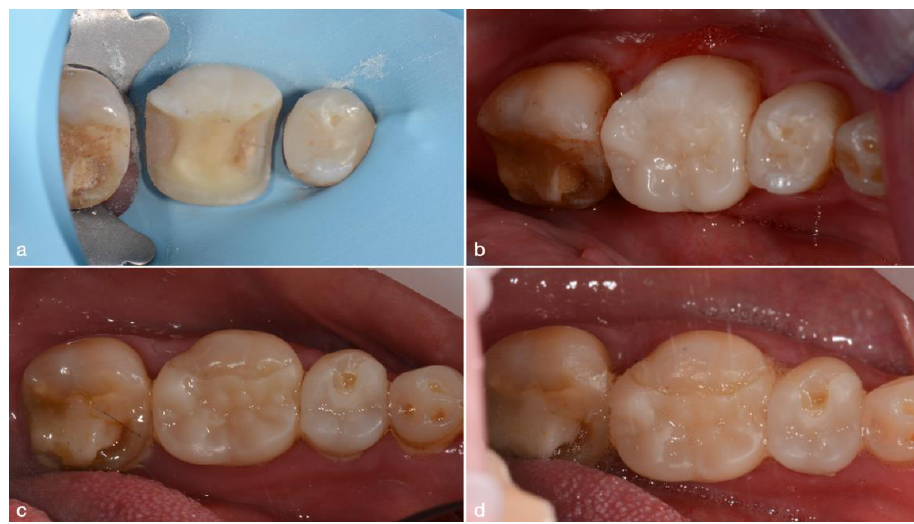
Figure 3. Images and descriptions of follow-up cases. Marginal adaptation: ( a ) Preparation at placement appointment; ( b ) immediately after placement of onlay on #36; ( c ) unintentional follow-up after 7 months of #36 due to placement of onlay on #35; ( d ) 36-month follow-up of #36. Table 5. USPHS scores and Chi-Square statistics at baseline and endpoint per restoration type. The median and interquartile range of patient and operator satisfaction scores are de- picted in Figure 4. The overall mean VAS score for patient satisfaction was 86.5% ± 10.2% Baseline Recall session versus 77.0% ± 10.6% for operator satisfaction. The mean VAS score for patient satisfaction Category In/onlays Overlays Endocrowns Total Chi-Squared In/onlays Overlays Endocrowns Total Chi-Squared with the IOS procedure was 77.1% ± 24.7%, while satisfaction with the esthetic result and functionality of the restoration were 92.0% ± 7.0% and 90.6 % ± 8.9%, respectively. For oper- ator satisfaction, a mean VAS score of 70.7% ± 18.7% was calculated with the overall